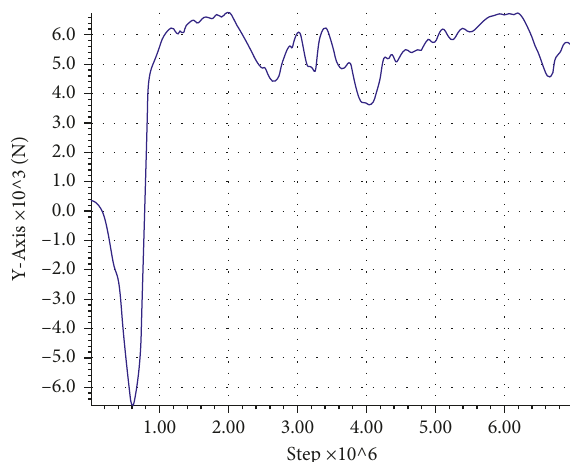
Figure 16: Axial force diagram of the anchor pile No. 3 with a rock- socketed depth of 15